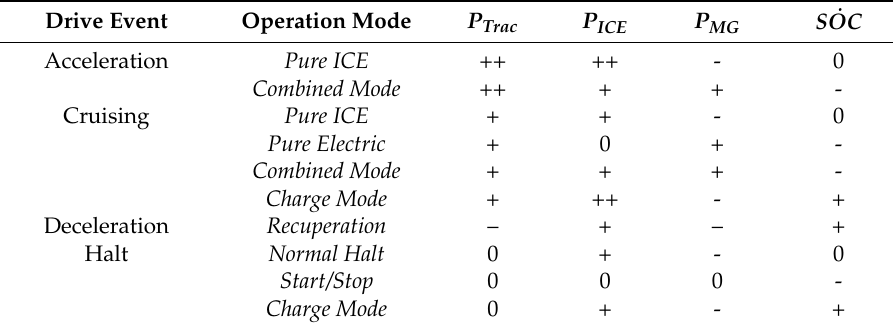
Table 3. Drive Events and Hybrid Operation Modes.